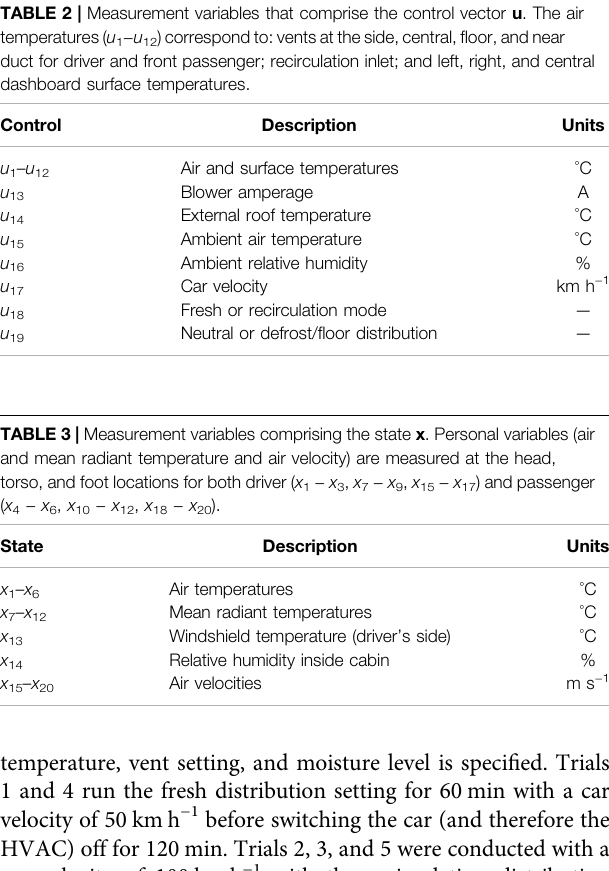
TABLE 2 | Measurement variables that comprise the control vector u . The air temperatures( u 1 − u 12 )correspondto:ventsattheside,central, fl oor,andnear duct for driver and front passenger; recirculation inlet; and left, right, and central dashboard surface temperatures.